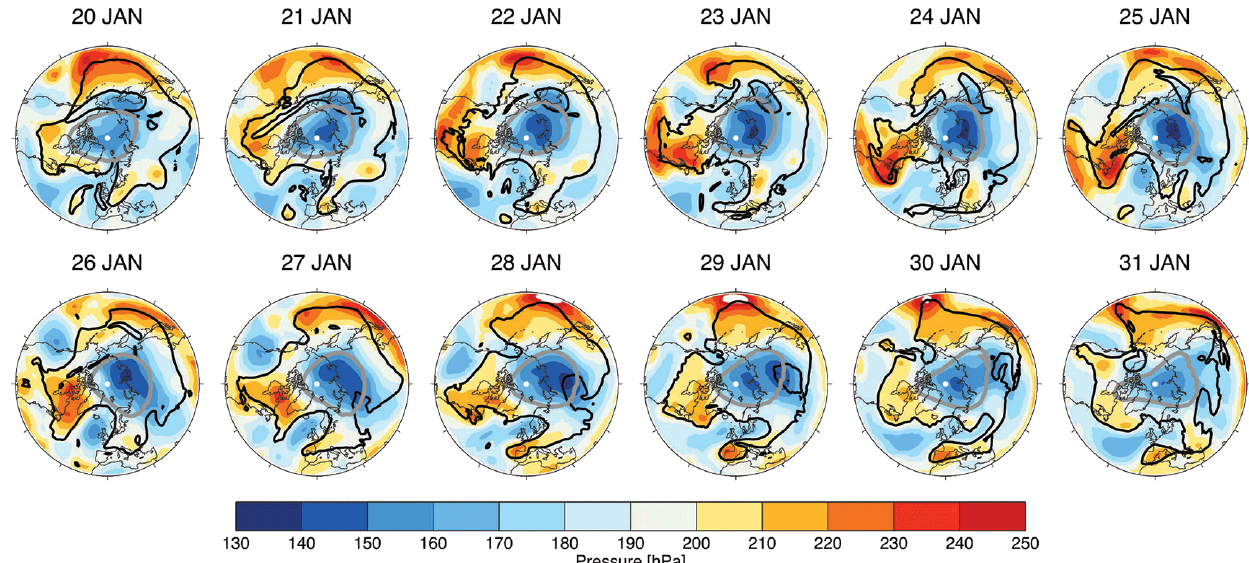
Fig. 17. As in Fig. 15 except for pressure at the 350K isentropic